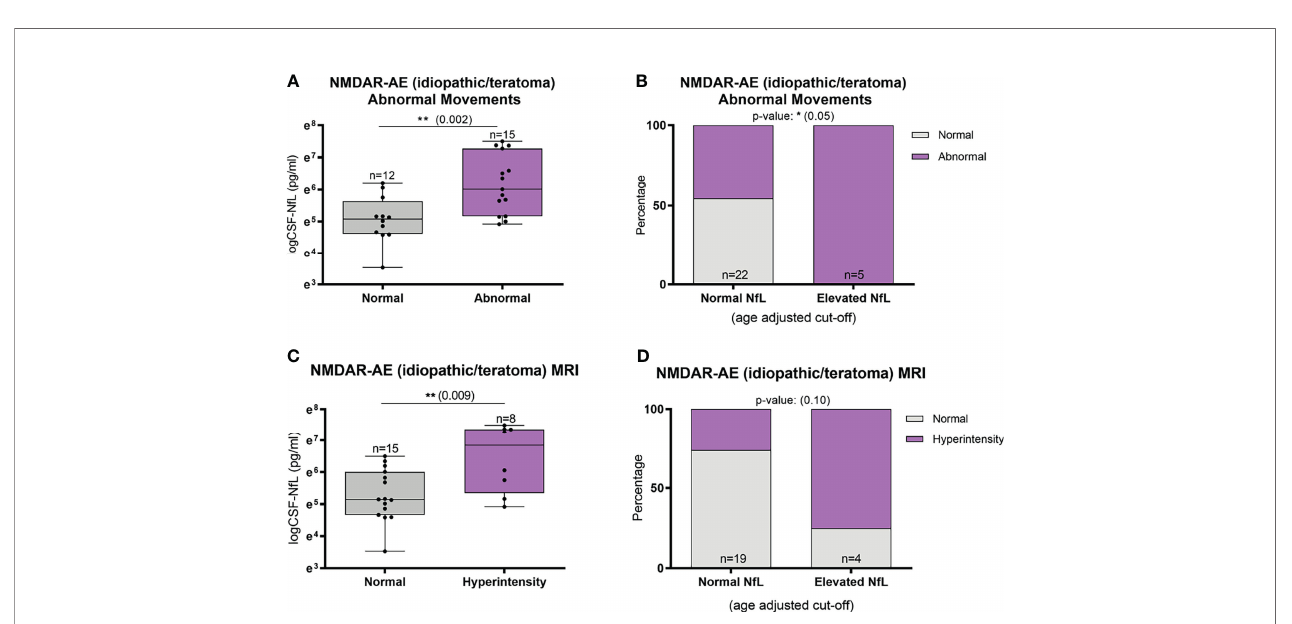
FIGURE 4 | CSF-Neuro fi lament light chain (NfL) levels in relation to abnormal involuntary movements and MRI fi ndings in idiopathic/teratoma associated NMDAR-AE patients. Patients with NMDAR-AE (idiopathic or teratoma) and abnormal movements had higher NfL levels at diagnosis (A) , and all patients with elevated NfL levels presented abnormal movements (B) . MRI hyperintensities on T2/FLAIR sequences were associated with higher NfL levels at diagnosis in idiopathic/teratoma associated NMDAR-AE (C) , and majority of patients with MRI changes had elevated CSF-NfL levels at diagnosis (D) . *p value < 0.05, **p value < 0.01.